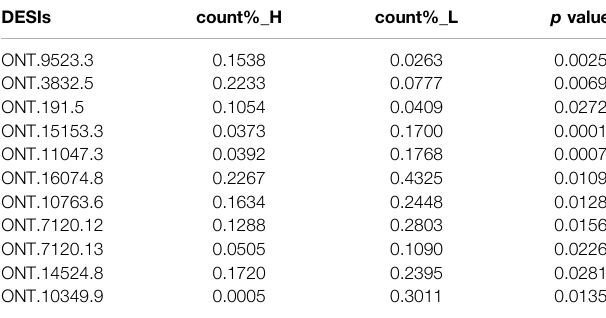
TABLE 4 | Proportion of splicing isoforms expression in Group H and L.